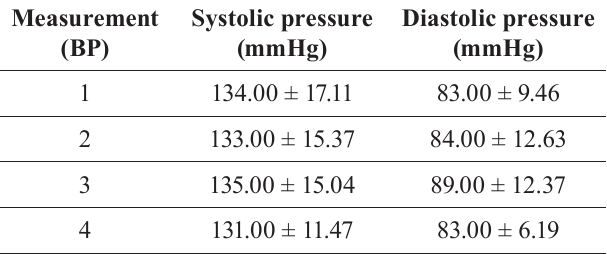
TABLE II - Mean and standard deviation of blood pressure (BP) of patients performed during collections and home visits